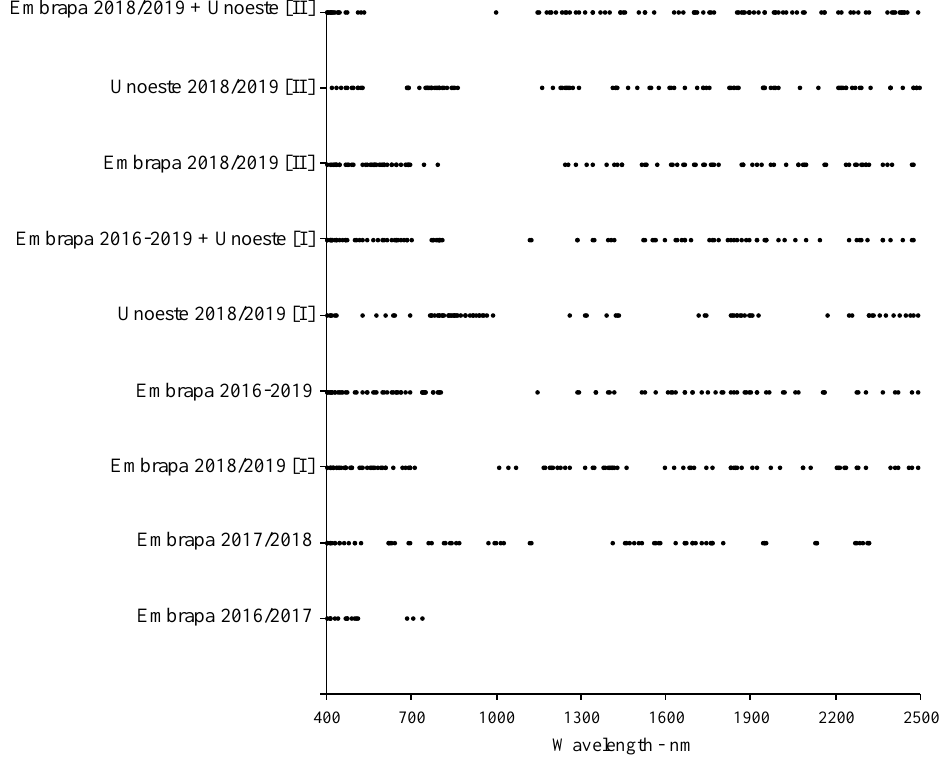
Figure 9. Spectral wavelengths (black dots) selected in the stepwise procedure of each spectral dataset. It is possible to observe that many wavelengths are significant ( p < 0.05) to differen- tiate the soybean genotypes within each spectral dataset. The lowest number of selected wavelengths, 16, was obtained for the ‘Embrapa 2016/2017’ spectral dataset and the max- imum for the ‘Embrapa 2018/2019 + Unoeste [II]’ spectral dataset, 138. The numbers of selected wavelengths in each spectral dataset were: 75 (Embrapa 2017/2018), 96